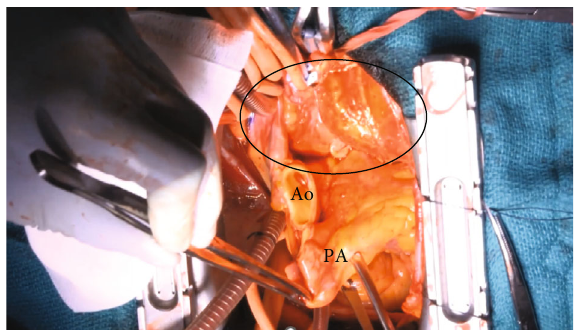
Figure 3: Operative image. The ascending aorta and main pulmonary artery were transected, and a mass was found on the posterior surface of the heart.